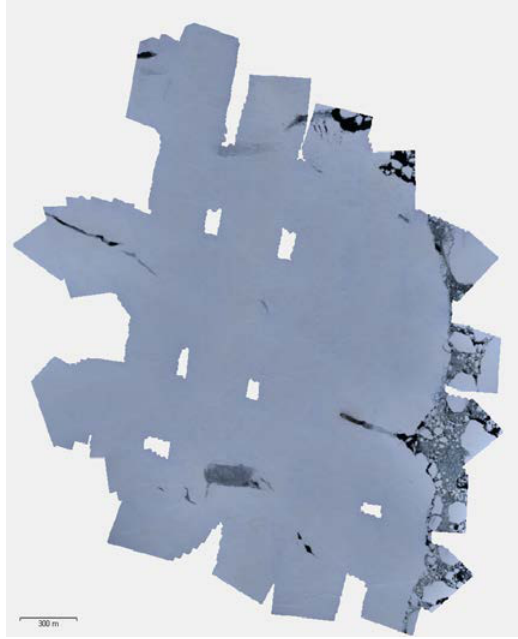
Figure 6. Mosaicked image generated from sea ice drift compensated